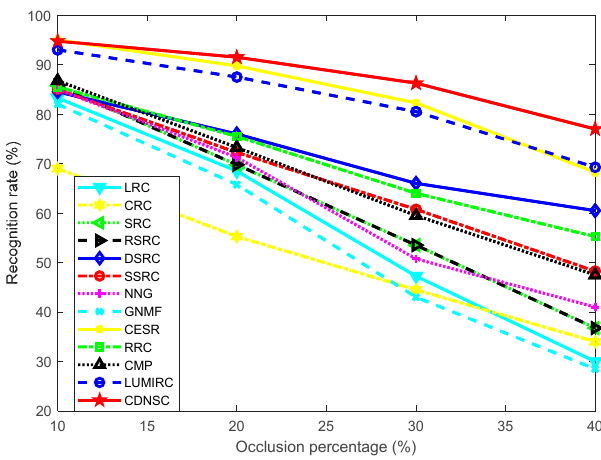
Figure 7. Recognition rate versus the level of scar occlusion.